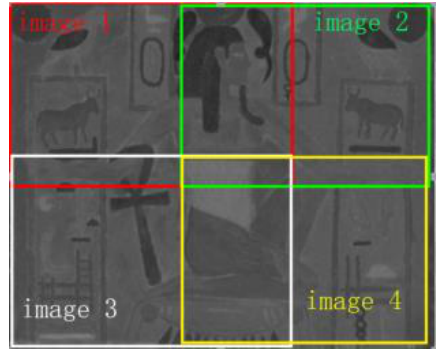
Figure 14. One to one correspondence between local image and point cloud 4.